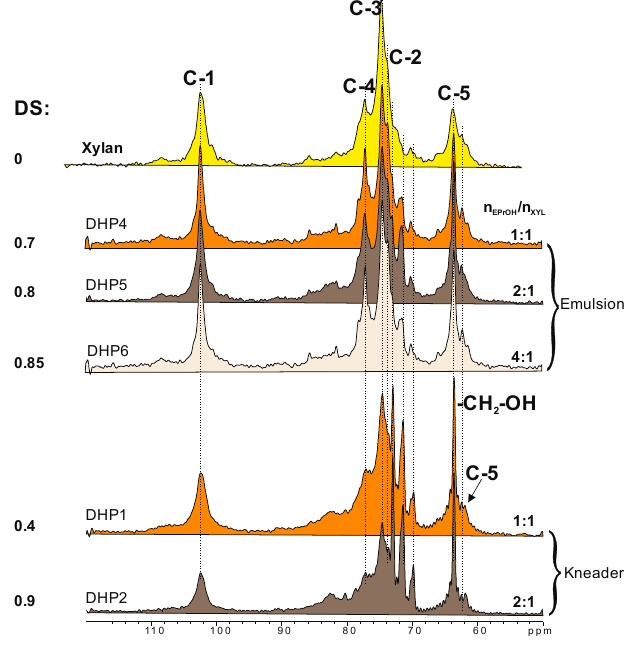
Figure 5. Solid-state 13 C-NMR (CP/MAS) spectra of selected dihydroxypropyl xylans.